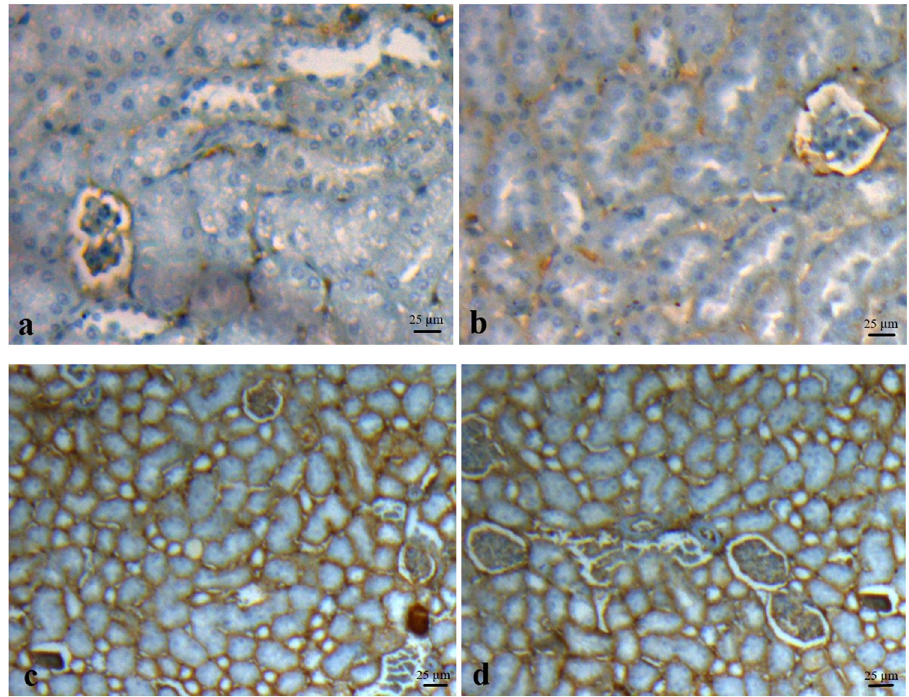
Figure 3: p53 immunoreactivity in the kidney tissue: ( a ) Quite poor immunoreactivity in the control group, ( b ) moderate immunoreactivity in the sinusoidalepithelium in 5 mg kg − 1 acetamiprid group and poor immunoreactivity in the tubular epithelium and glomerular cells, ( c ) strong immunoreactivity in the sinusoidal epithelium and glomerular cells in 10 mg kg − 1 acetamiprid group, and ( d ) strong immunoreactivity in the sinusoidal epithelium and glomerular cells in 15mgkg − 1 acetamiprid group, and moderate immunoreactivity in the tubular epithelium, IHC - P, bar: